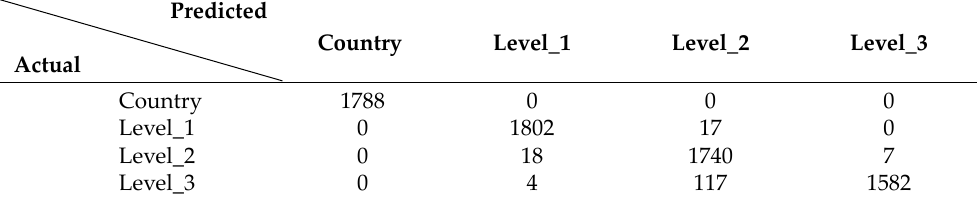
Table 3. Confusion matrix.